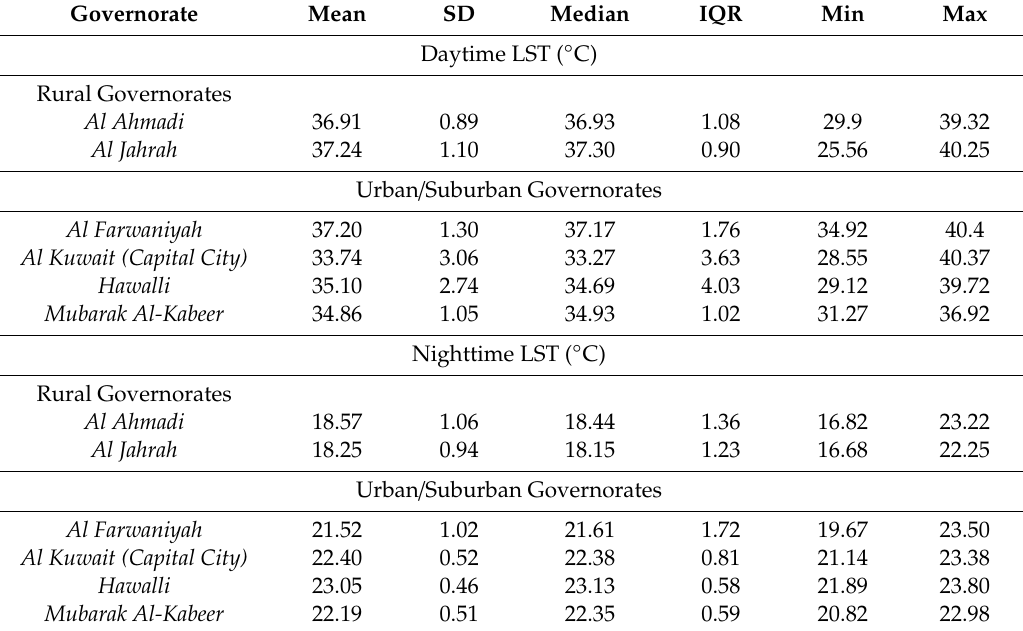
Figure 2. Time trends of land surface temperature (LST) in Kuwait, stratified by daytime and nighttime from January 2001 to March 2017. Table 1. Descriptive statistics of average surface temperatures in Kuwait